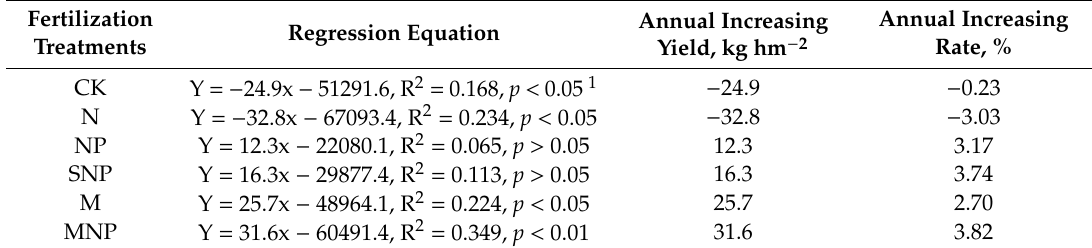
Table 3. The trend of basic soil productivity of winter wheat.